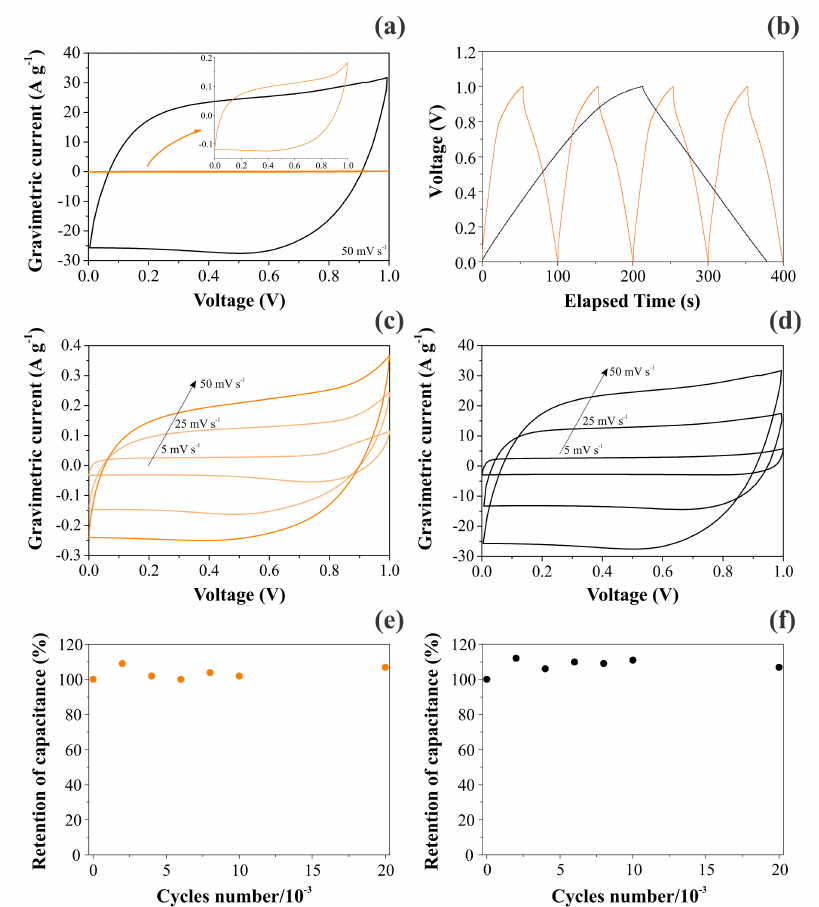
Figure 7. Electrochemical findings for CNFs (left) and NiO@CNFs (right) electrodes in symmetric coin cells filled with a 1.0 M Li 2 SO 4 aqueous solution: ( a , c , d ) the scan rate is indicated in the figure; ( b ) GCD profiles obtained at 0.4 A g − 1 for CNFs and 4 A g − 1 for NiO@CNFs; ( e , f ) the cyclability test